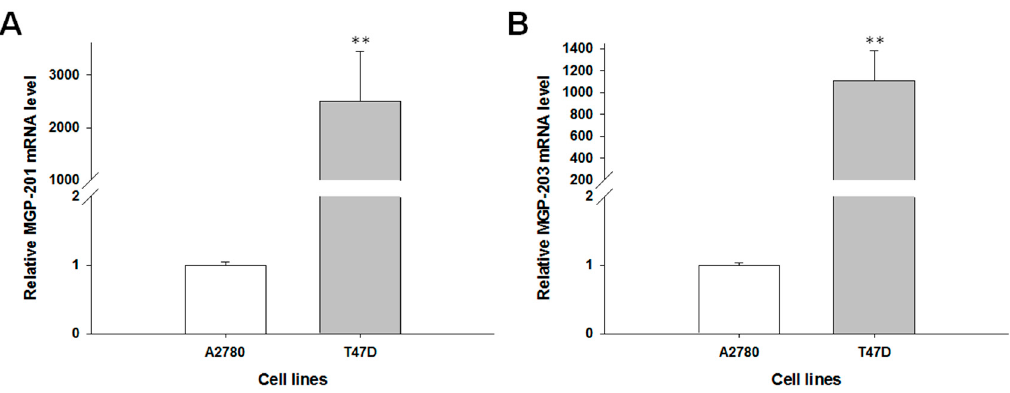
Figure 2. Expression analysis (Q-PCR) of the MGP1-201 ( A ) and MGP-203 ( B ) transcripts. The figure presents the relative gene expression in the breast cancer cell line T47D (grey bars) with respect to that in the control ovarian cancer cell line A2780 (white bars), which was assigned a value of 1. The values were considered significant at ** p < 0.01.